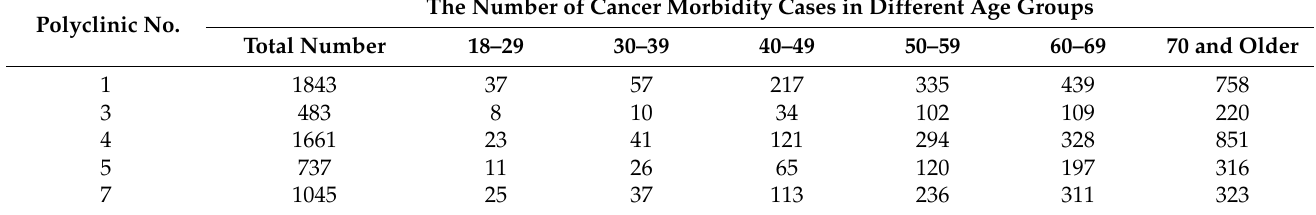
Table 1. Dependence of the number of the cancer morbidity cases on age